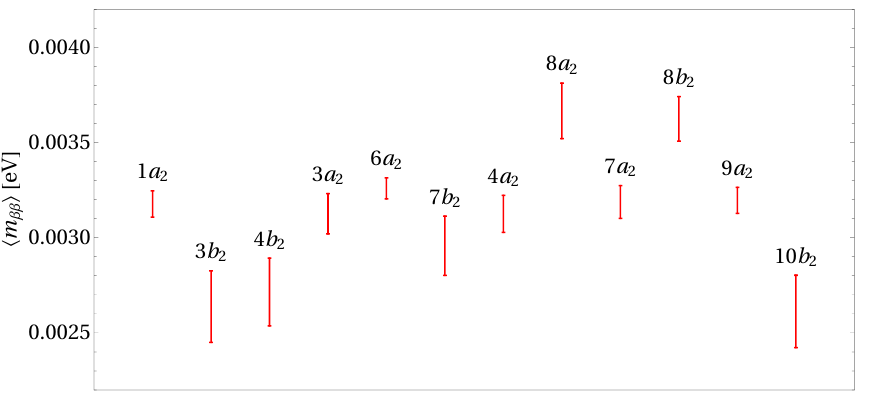
Figure 6 . Predictions for the e(cid:11)ective mass h m (cid:12)(cid:12) i in neutrinoless double-beta decay in the best (cid:12)t models. For the 12 best (cid:12)t points with lowest (cid:31) 2 listed in table 3 the 1 (cid:27) HPD intervals for h m (cid:12)(cid:12) i are shown as red